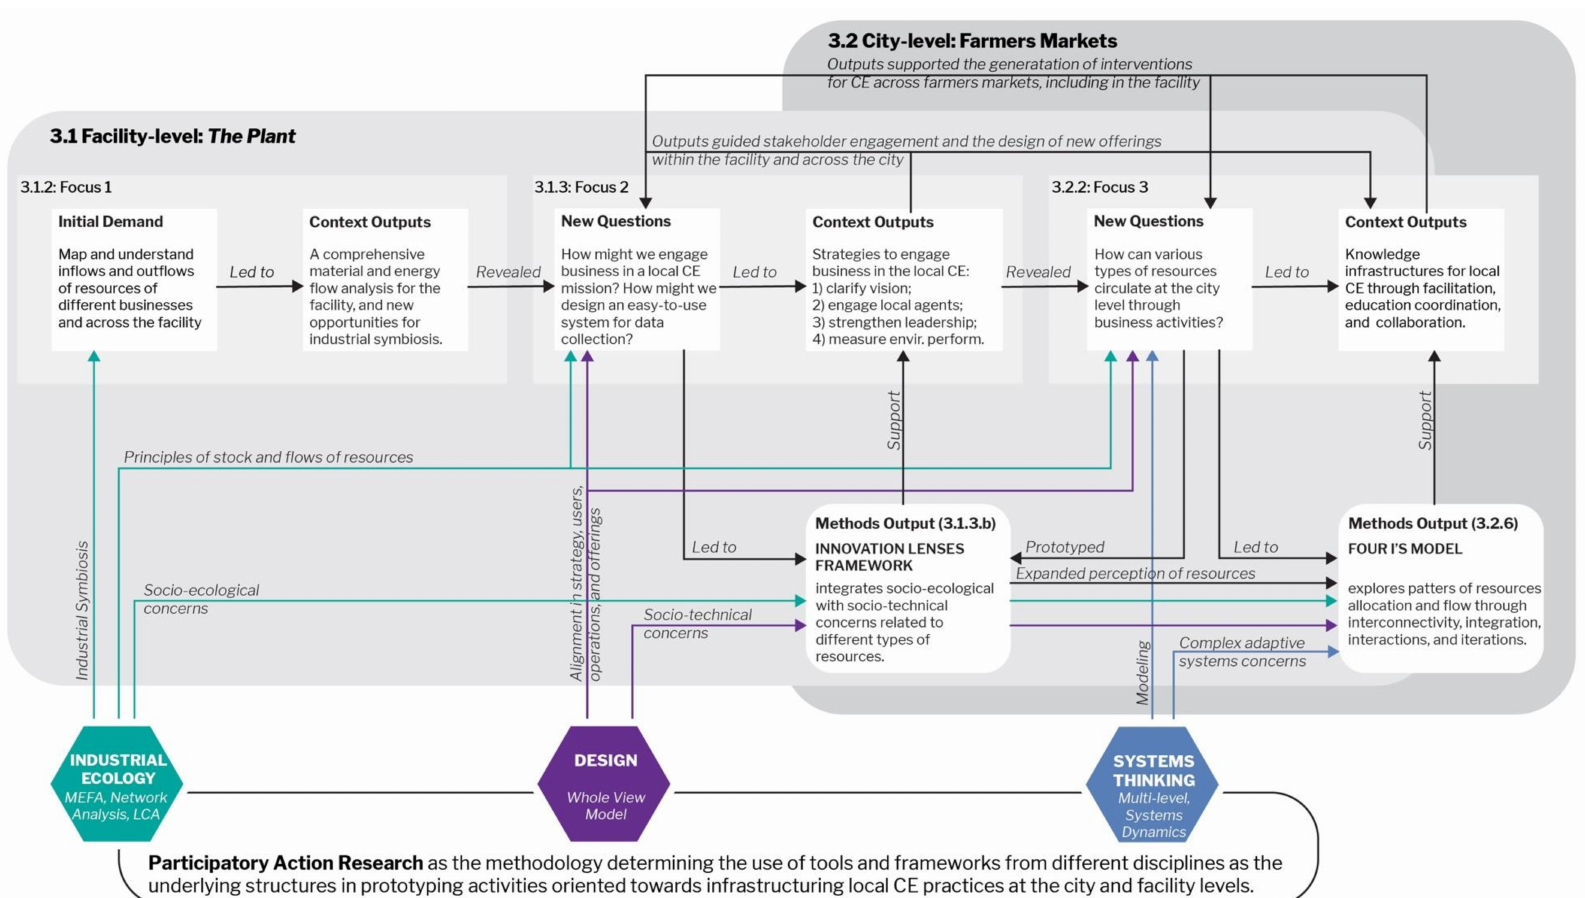
Figure 2. Iterative development of methods and results across facility and city-level projects. Abbreviations: CE, circular economy; MEFA, material and energy flow analysis; LCA, life cycle